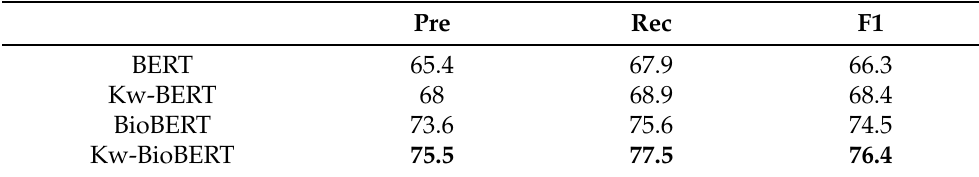
Table 5. Ablation study. The highest value of each metric is marked in bold.